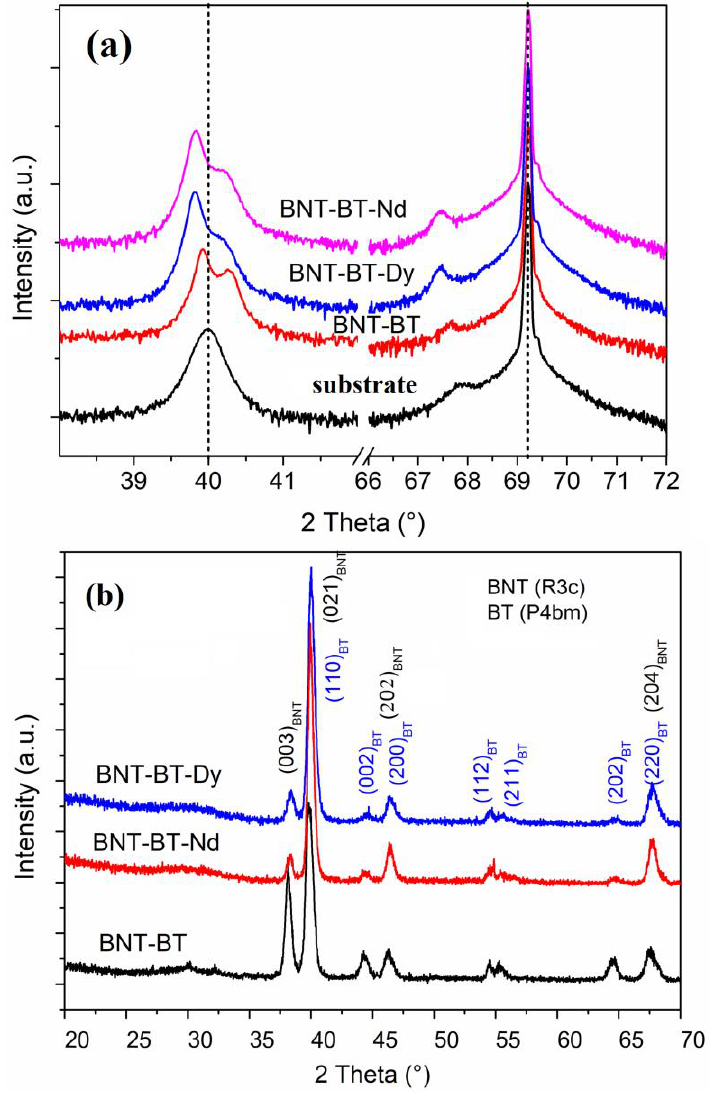
Figure 3. ( a ). Room-temperature X-ray diffractograms of BNT-BT, BNT-BT-RE (RE = Nd and Dy), and of the substrate, with a zoom of the X-ray diffraction patterns around 40° and 69°, and ( b ) X-ray diffractograms of the investigated films measured under grazing incidence mode.